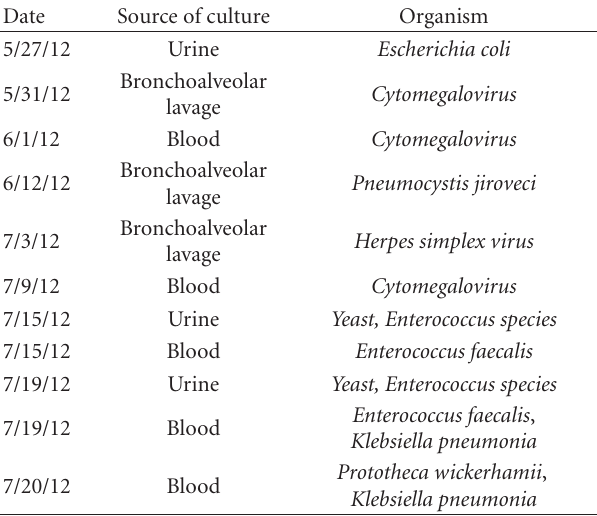
Table 1: Positive microbiology cultures during